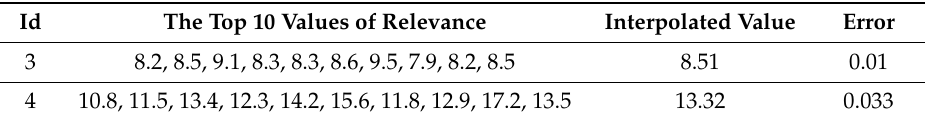
Table 7. The results of interpolating missing